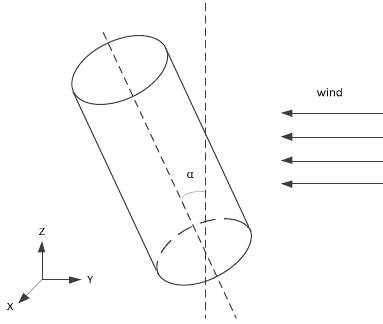
Figure 5. The definition of the inclination angle of the wind sensor.